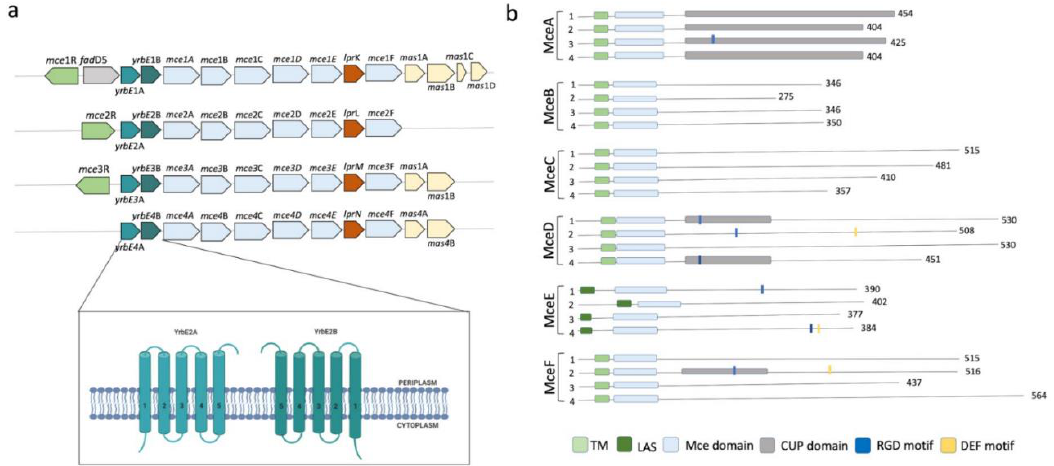
Figure 3. Characteristics of the Mce components of Mycobacterium tuberculosis . ( a ) Genomic organization of the four mce clusters. mceR: regulator (green); fad D5 (gray); yrbAB : ABC transporter integral membrane components (cyan and green, respectively); mceA to mceF: periplasmic-binding proteins (clear blue); lprKLMN: (red); masABCD: (pale yellow). The topology of the transmembrane domains is shown in detail, consisting of 10 helical transmembranes, 5 from each component. ( b ) Different domains and motifs present in the periplasmic components of MceA, MceB, MceC, MceD, and MceF. TM: transmembrane region; LAS: lipid-associated region; CUP: cholesterol uptake porter domain; RGD: motifs for putative integrin binding; DEF: probably motif for ERK2 binding. Each mce operon (Mce1 to Mce4) encodes six Mce proteins (MceA-F) that span the bacillus